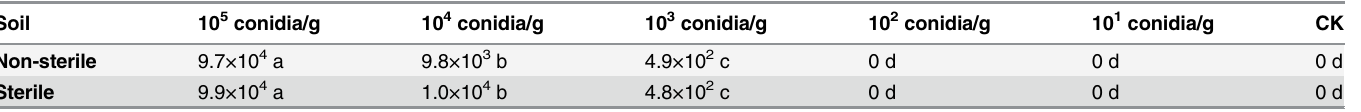
Table 3. CFU values obtained from inoculated soils with L . lecanii conidia on the selective medium (OA-CTAB5) a .